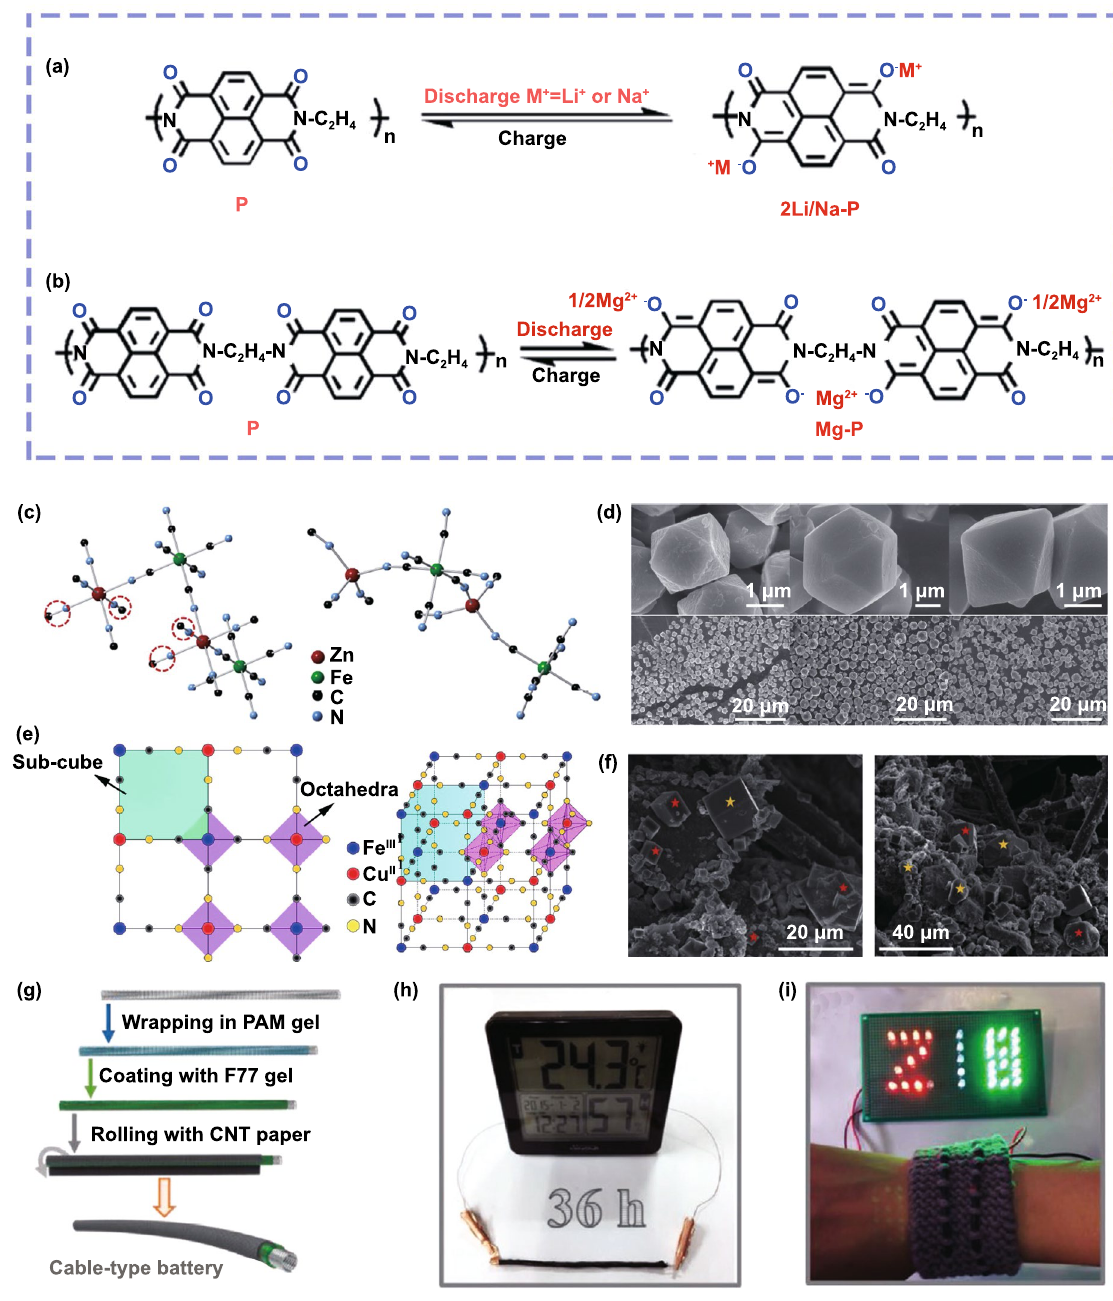
Fig. 10 a Electrochemical redox mechanism (insertion and extraction) of polyimide with Li + and Na + . b Electrochemical redox mechanism (insertion and extraction) of polyimide with Mg 2+ . Reproduced with permission from Ref. [124]. Copyright 2017, American Chemical Society. c Coordination environments for Zn and Fe atoms in cubic structure (left) and rhombohedral structure (right) of Zn 3 [Fe(CN) 6 ] 2 . d SEM and TEM images of cuboctahedron, truncated octahedral and octahedral Zn 3 [Fe(CN) 6 ] 2 . Reproduced with permission from Ref. [17]. Copyright 2015, Nature publishing Group. e Crystal structure of KCuFe(CN) 6 nanocube. Reproduced with permission from Ref. [125]. Copyright 2015, Elsevier. f SEM images of CuZnHCF (93:7). Reproduced with permission from Ref. [129]. Copyright 2019, Elsevier. g Schematic illustration for the fabrication of the cable-type Zn/CoFe(CN) 6 battery. h An electronic hygrometer powered by a cable-type battery. i A textile wristband integrated with two cable batteries connected in series as power accessory for different color LEDs. Reproduced with permission from Ref. [77].